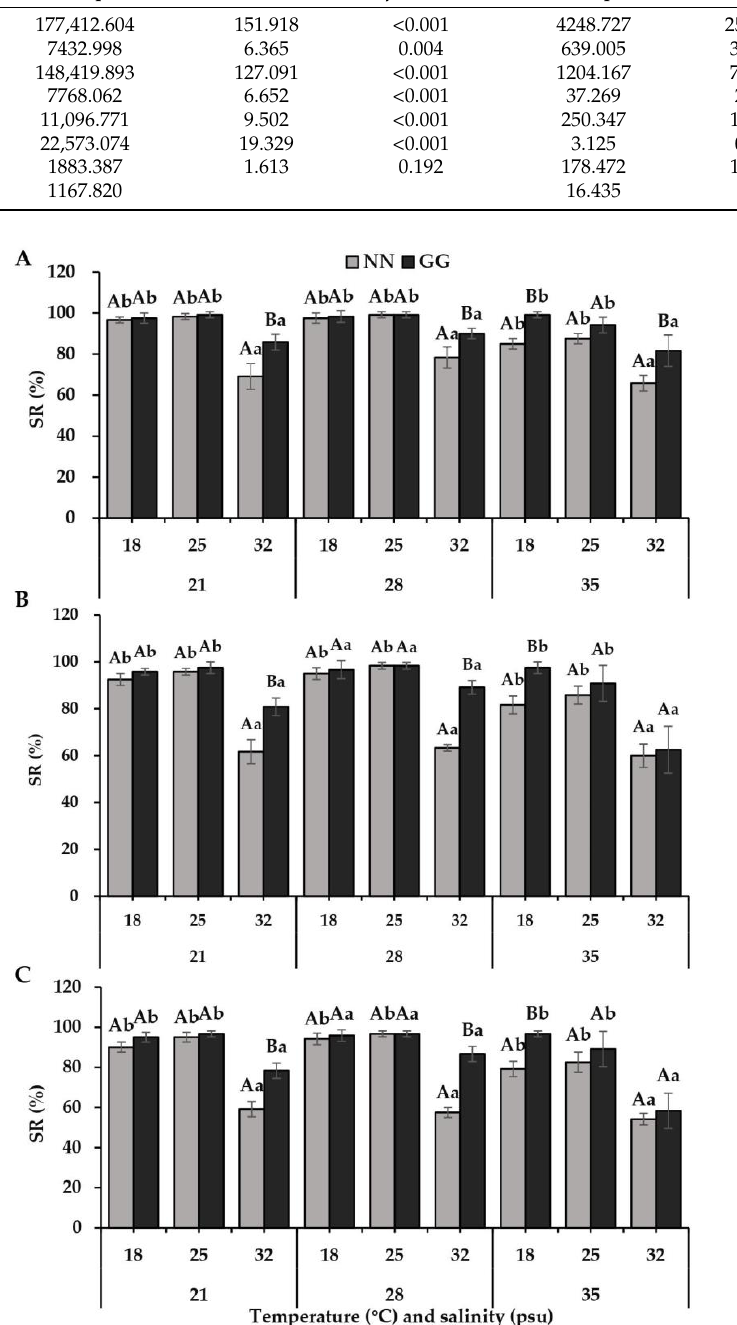
Figure 3. Comparison of the survival rate (SR) of C. nippona and C. gigas spat exposed to different combinations of temperatures (18, 25 and 32 °C) and salinities (21, 28 and 35 psu) on day ( A ) 10, ( B ) 20 and ( C ) 30. Different lowercase letters indicate significant differences at different temperatures for the same salinity level within the same species, while different uppercase letters represent significant differences between the NN and GG groups at the same environmental condition ( p < 0.05).